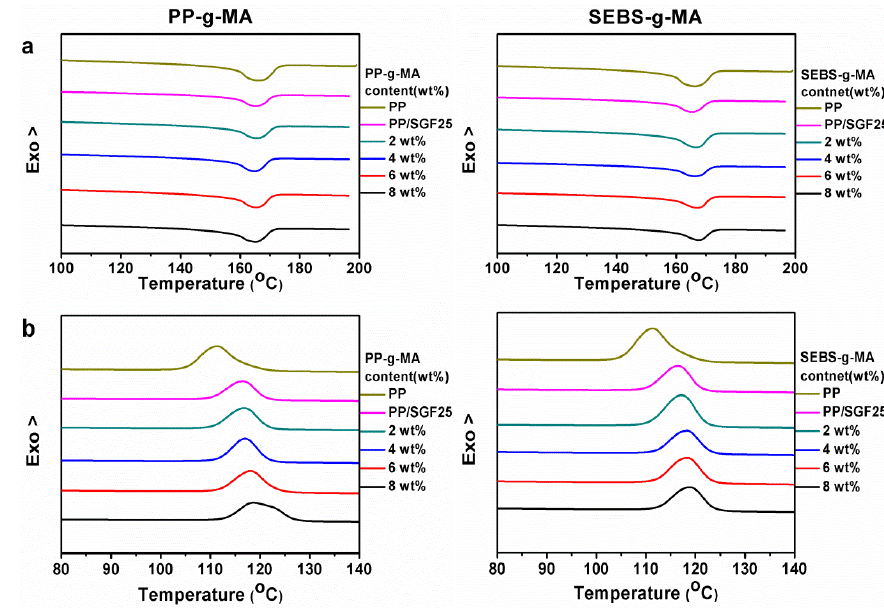
Figure 6. DSC curves for ( a ) melting behavior and ( b ) crystallization behavior of PP/SGF composites.